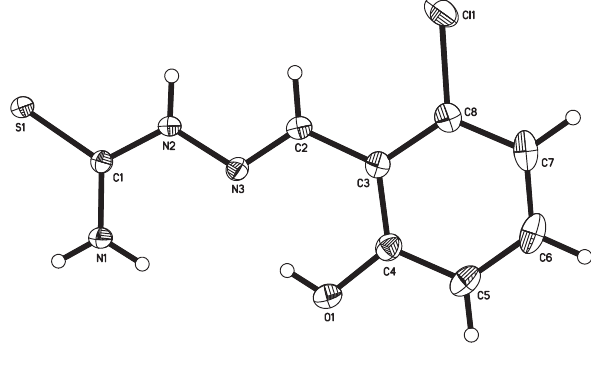
Table 2: Fractional atomic coordinates and isotropic or equivalent isotropic displacement parameters (Å 2